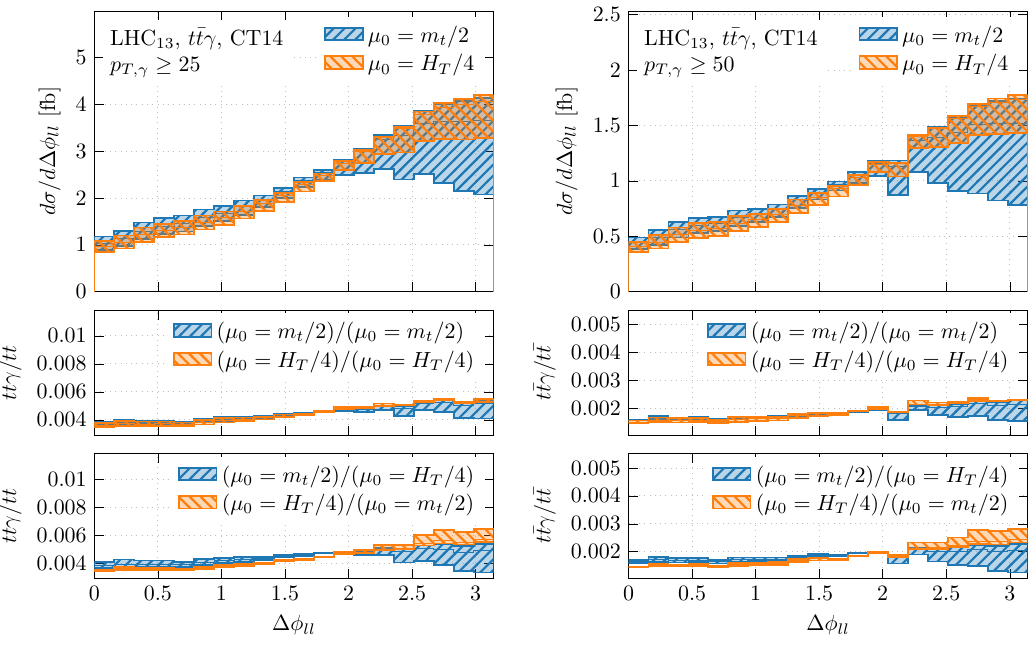
(cid:22) b(cid:13) + (cid:0) (cid:22) (cid:23) + (cid:23) ‘‘ for the pp ! e e (cid:22) (cid:22) b